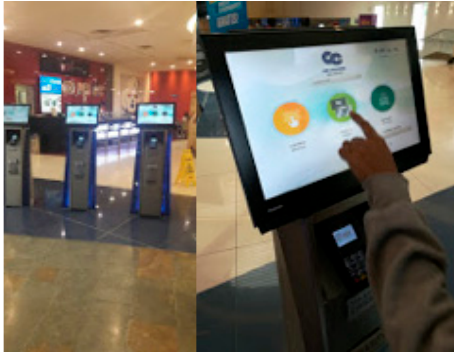
Figure 10. General overview and detailed closeup of cinema ticketing kiosk in Bogotá, Columbia.